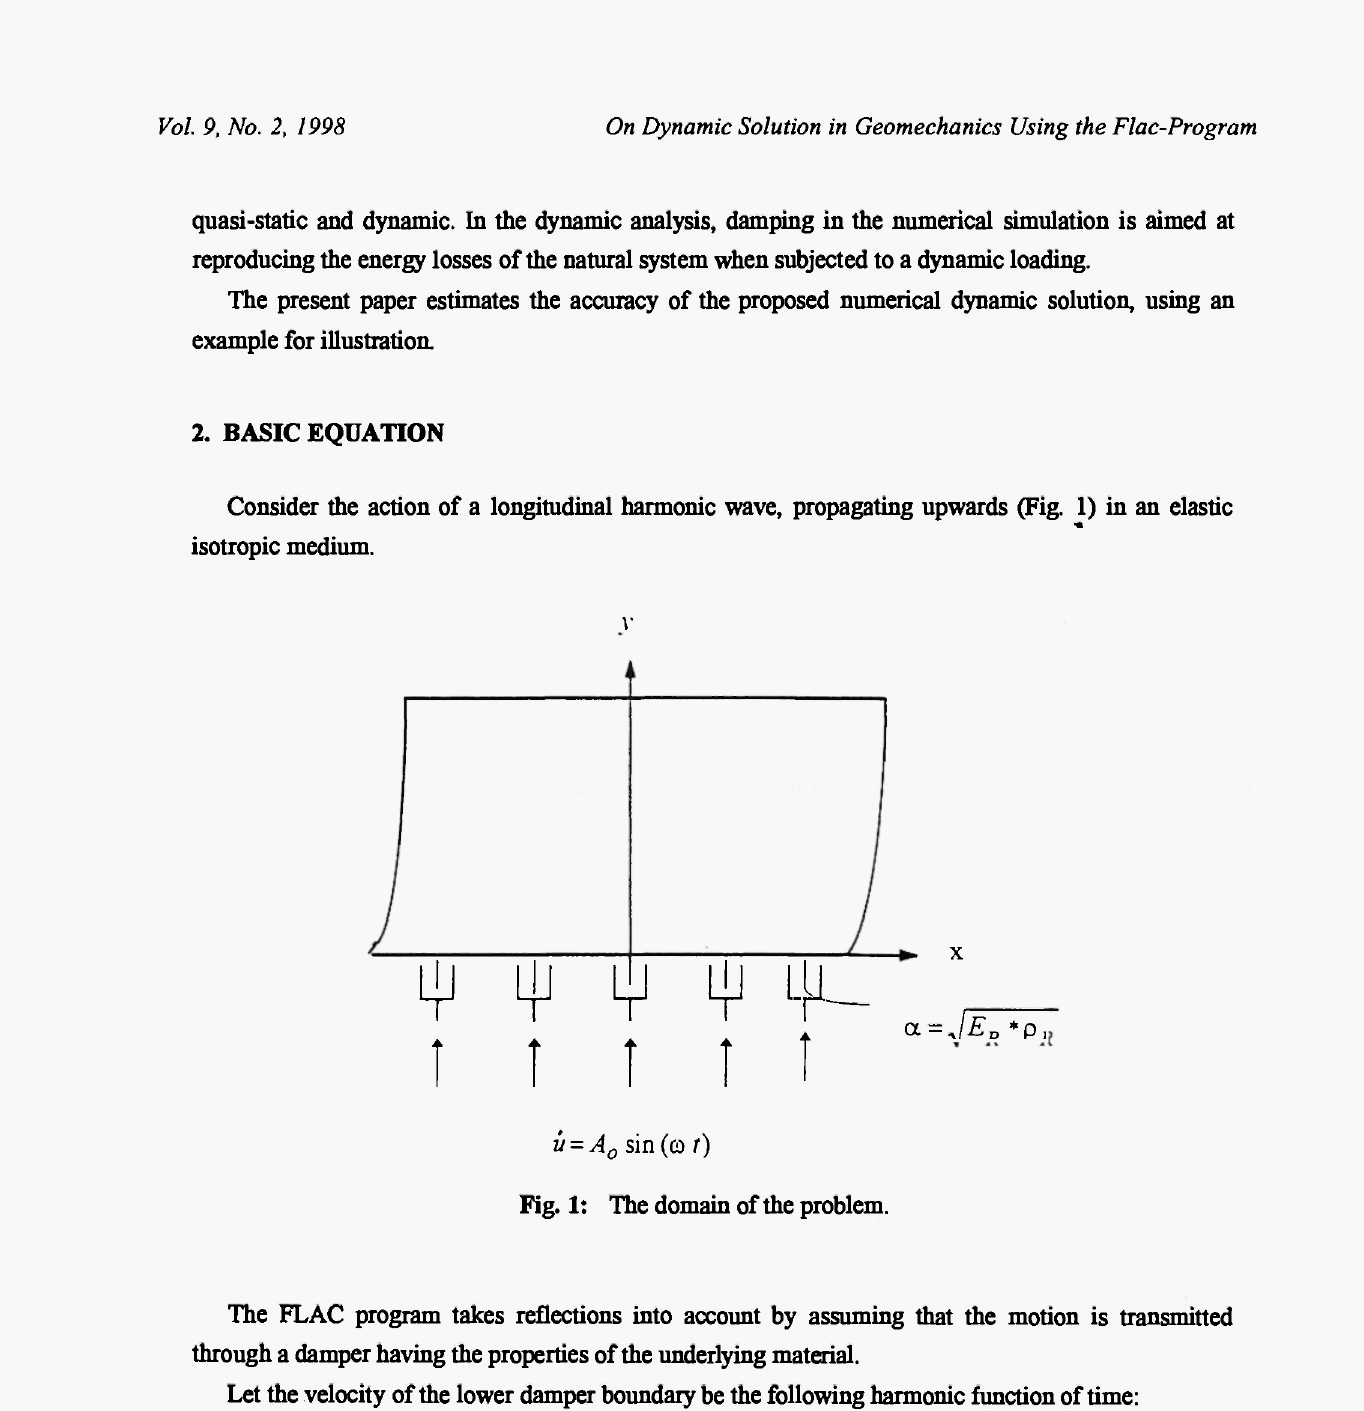
Fig. 1: The domain of the